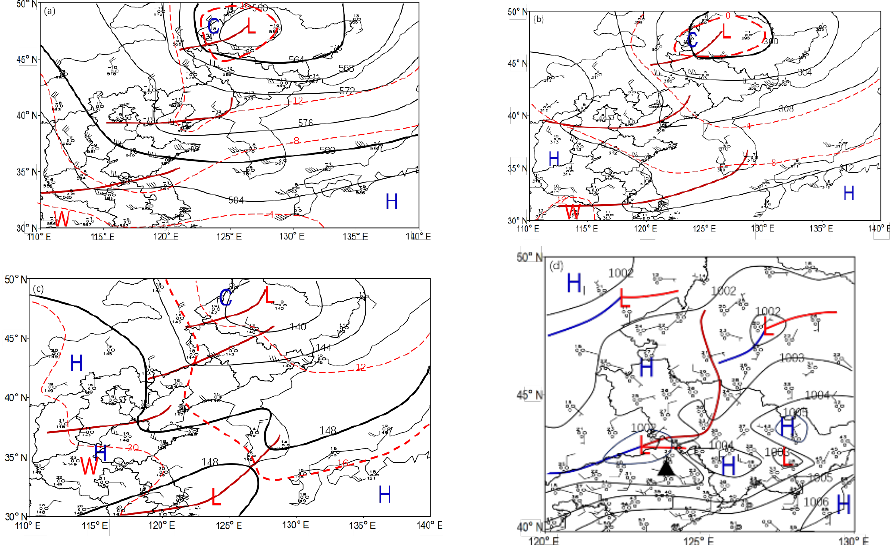
Figure 1. Upper synoptic charts ( a ) 500 hPa, ( b ) 700 hPa, ( c ) 850 hPa at 08:00 LST, and ( d ) surface synoptic chart at 17:00 LST, 3 July 2019. Black contours in ( a – c ) are isoheights (unit: dagpm). Black contours in ( d ) are isobars (unit: hPa). A full bar is 4 m · s − 1 . In ( d ), the blue lines are cold fronts, the red lines are warm fronts, and the brown line is an inverted trough. Kaiyuan is marked with a black